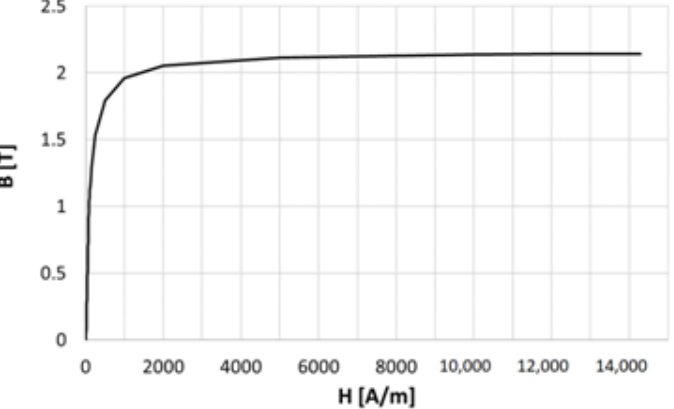
Figure 2. Measured magnetization curve of the magnetic core of tested measuring voltage transformer (VT) model.